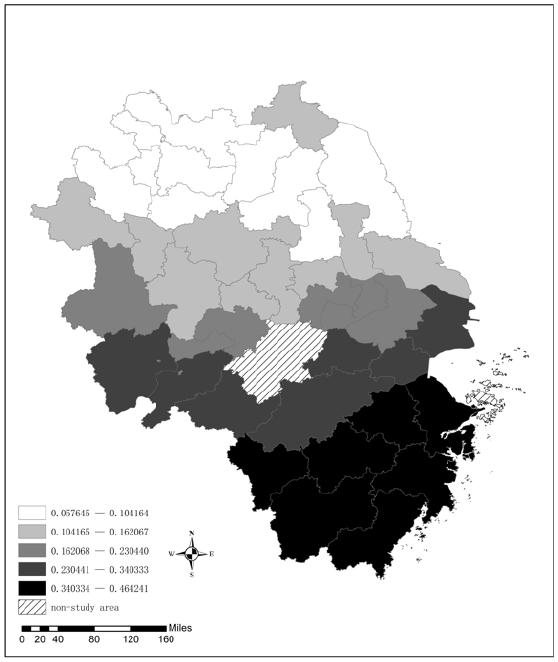
Figure 8. The spatial distribution of the regression coefficient for FDI .